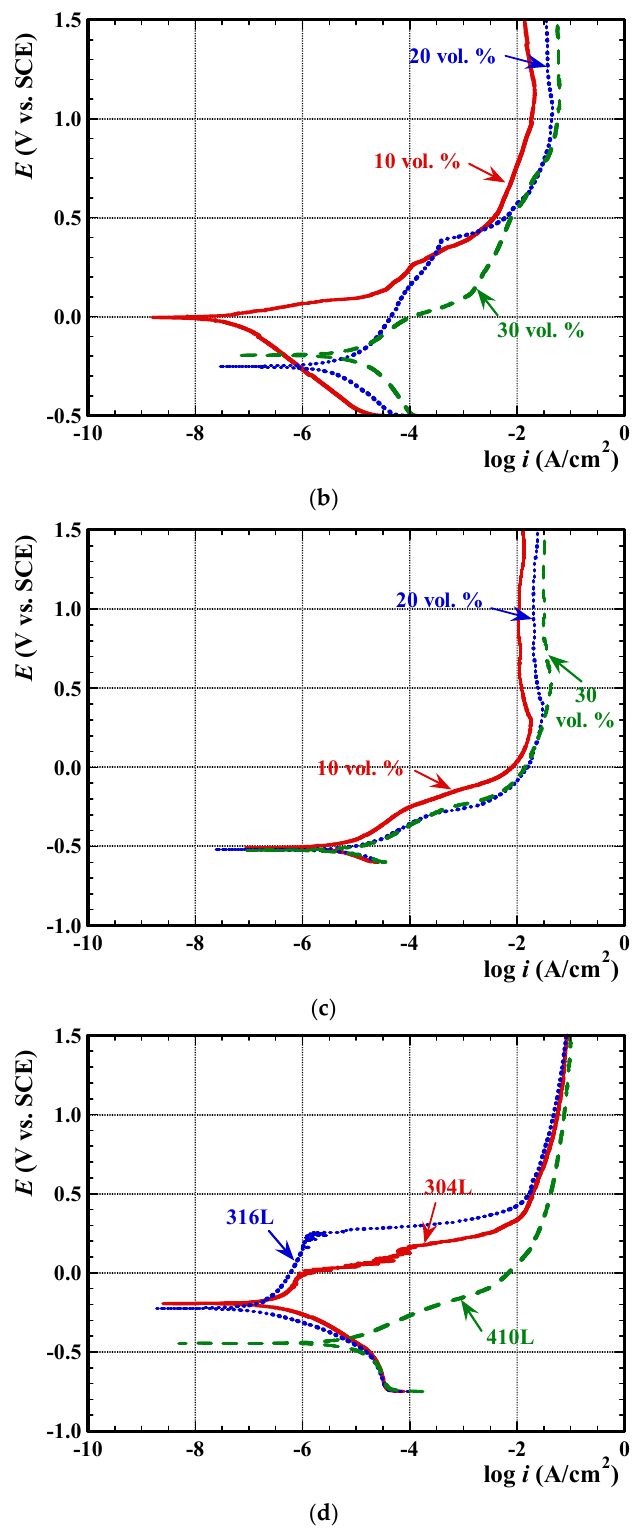
Figure 3. Representative potentiodynamic polarisation curves, demonstrating the effects of binder content for each of the TiC–stainless steel cermets, together with comparison of the single phase metallic stainless steels: ( a ) TiC-304 L; ( b ) TiC-316 L; ( c ) TiC-410 L; and ( d ) the baseline metallic grades of stainless steel.